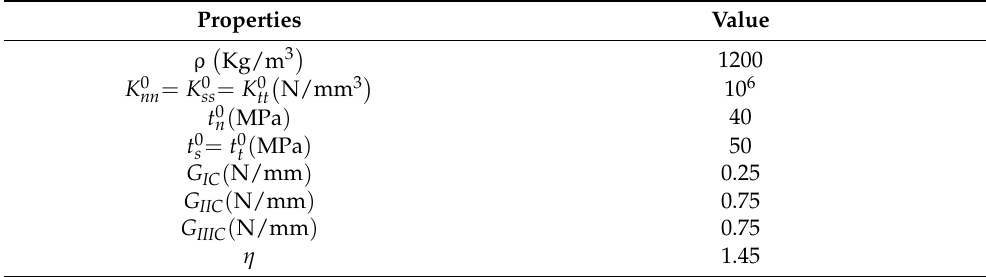
Table 6. Material properties of cohesive layers [16].